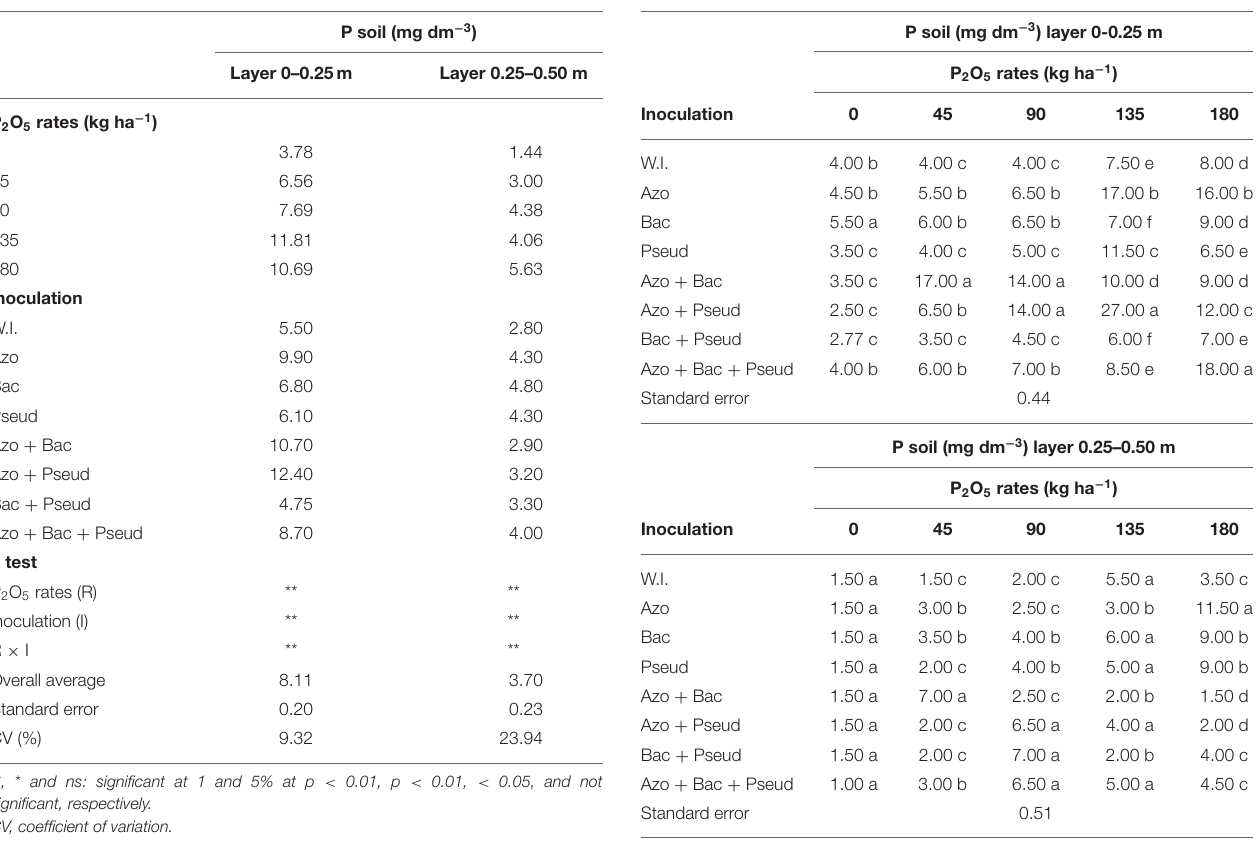
TABLE 2 | Available P contents in soil after cane harvest as influenced by inoculation of PGPB and P doses in sugarcane.